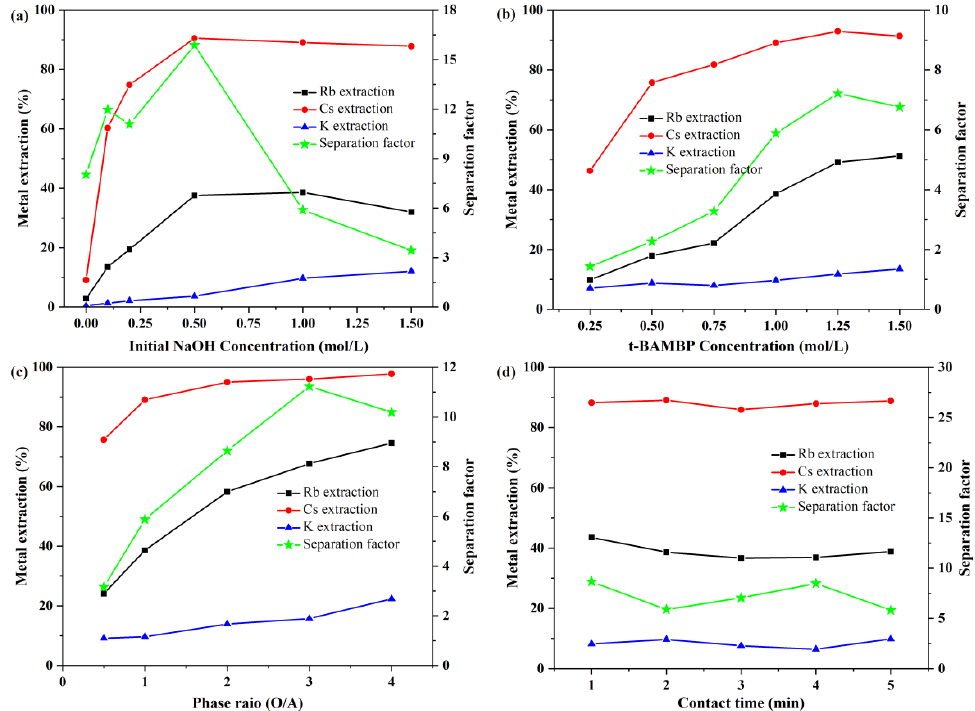
Figure 1. Effect of ( a ) NaOH concentration, ( b ) t-BAMBP concentration, ( c ) O/A ratio, and ( d ) contact time on metal extraction by the t-BAMBP/sulfonated kerosene system.